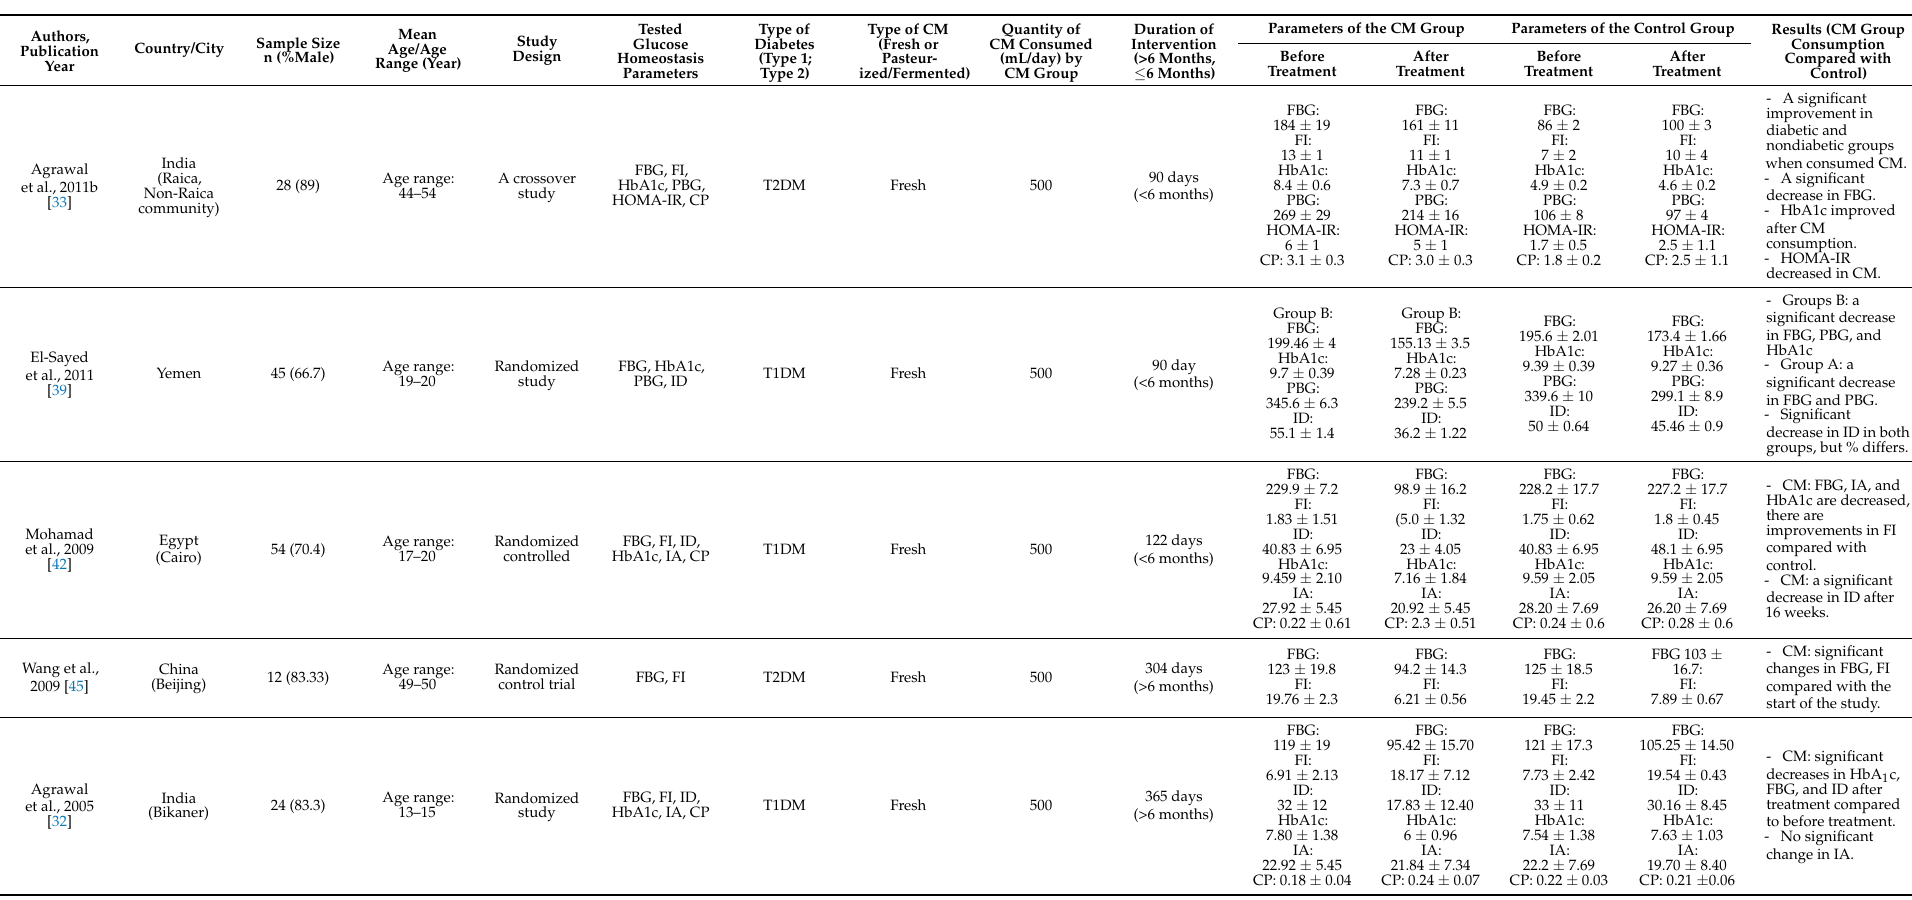
- CM:significant decreasesinHbA 1 c, FBG,andIDafter treatmentcompared tobeforetreatment. - Nosignificant